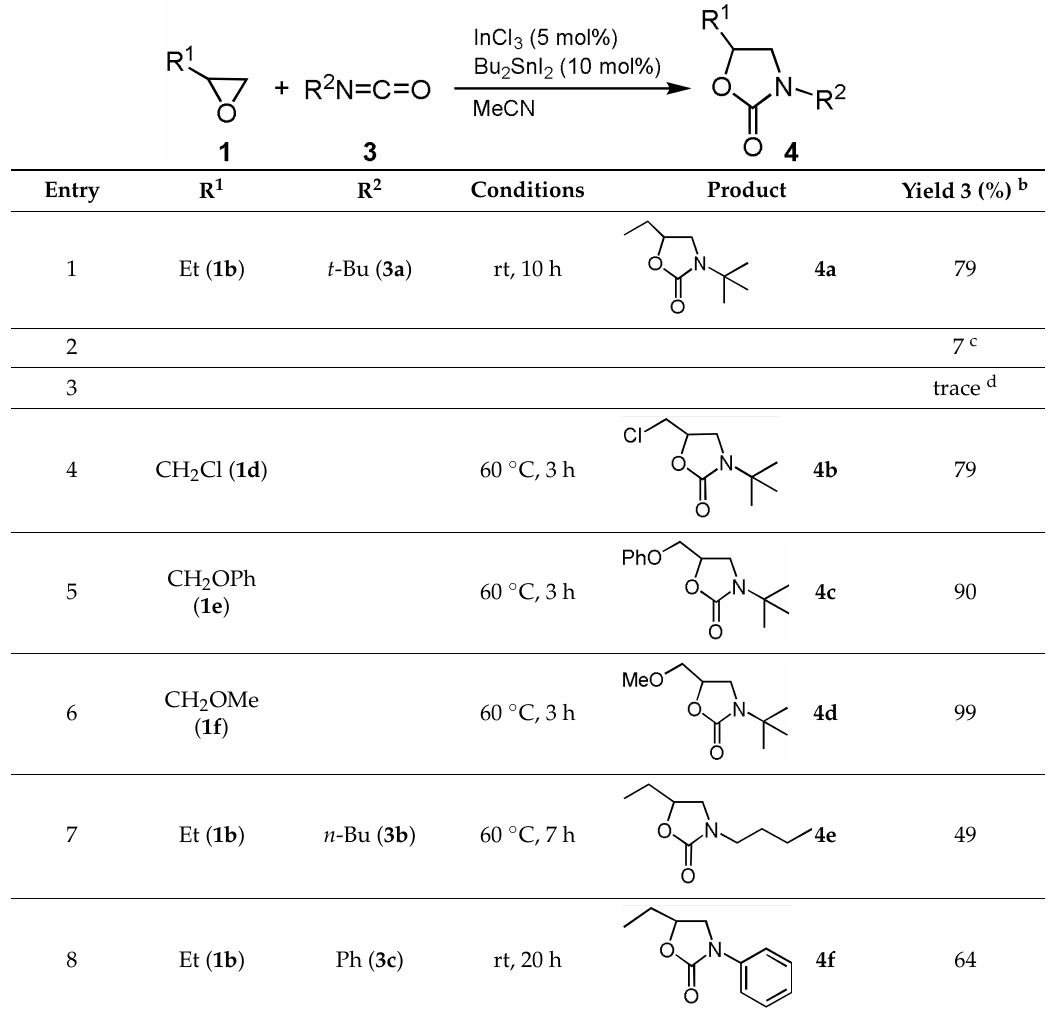
Table 2. Synthesis of 2-oxazolidinones 4 from epoxides 1b – f with isocyanates 3 a .